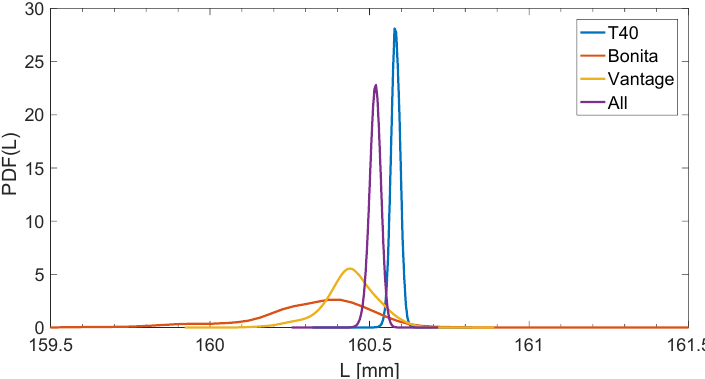
Figure 10. Variable PDF estimation of the same length measurement in OMC with different sets of cameras.